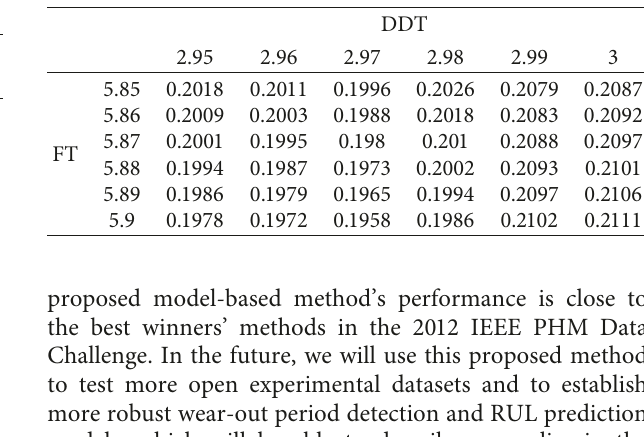
Table 4: Scores of exponential degradation